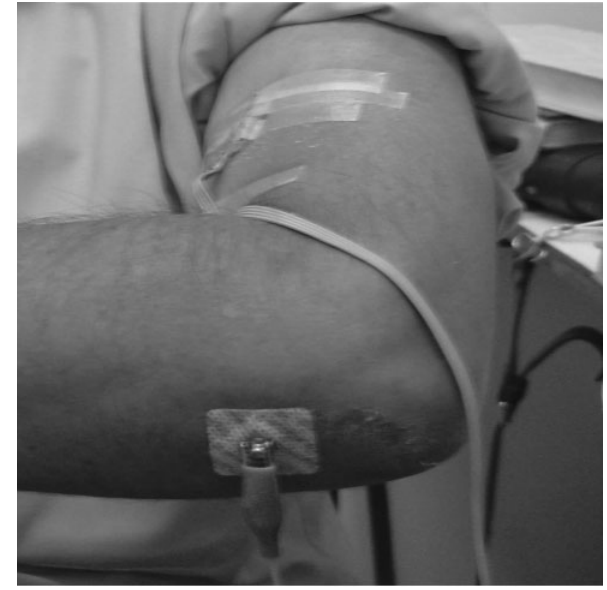
Figure 2 Electrode. Test on real